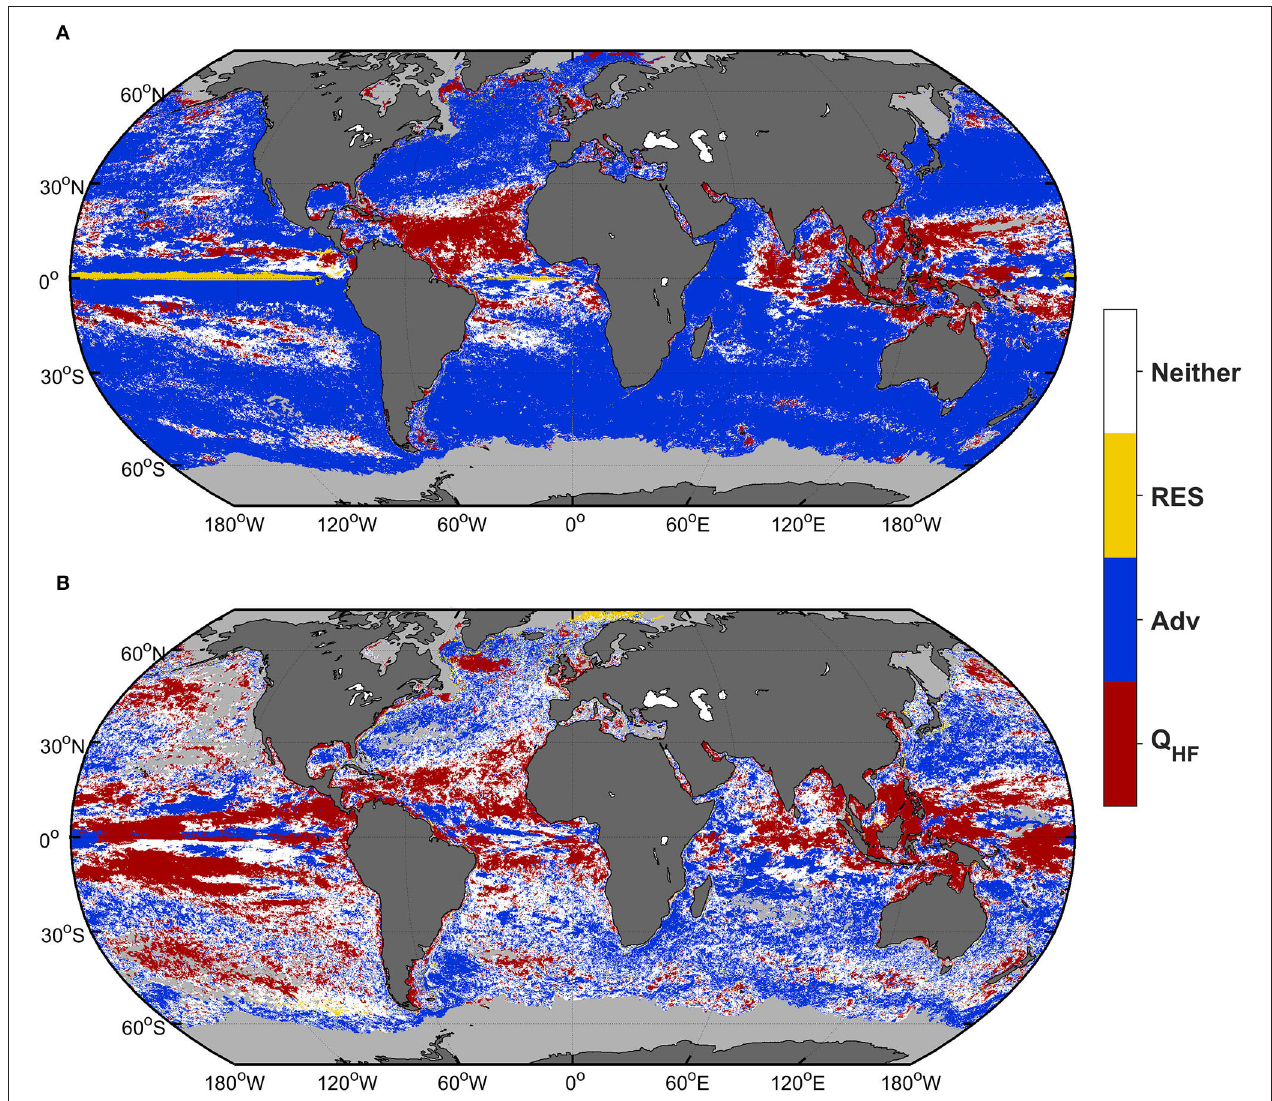
FIGURE 4 | Main driver of most extreme MHWs (A) onset ( n = 1–3) and (B) decay ( n = 1–3). A heat budget term was defined as the main term when the average percent contribution to the total temperature change during onset or decay period across all three most extreme MHWs was larger than 66.6%. Note that only positive contribution to total temperature change was considered. In the case where no term’s contribution was larger than 66.6%, the main driver was defined as “neither” (white), indicating that MHW onset or decay was driven by two or more terms. Net surface air-sea heat flux (red), total advection (blue) and the residual (yellow) term were considered [see Equation